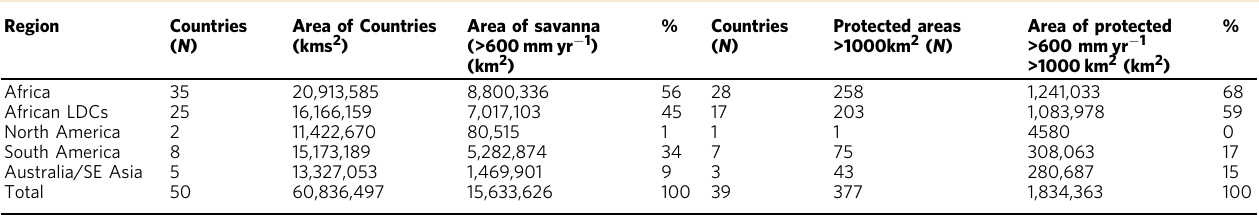
All savanna areas by country, and protected areas by country, are available in Supplementary Data 2 and 3